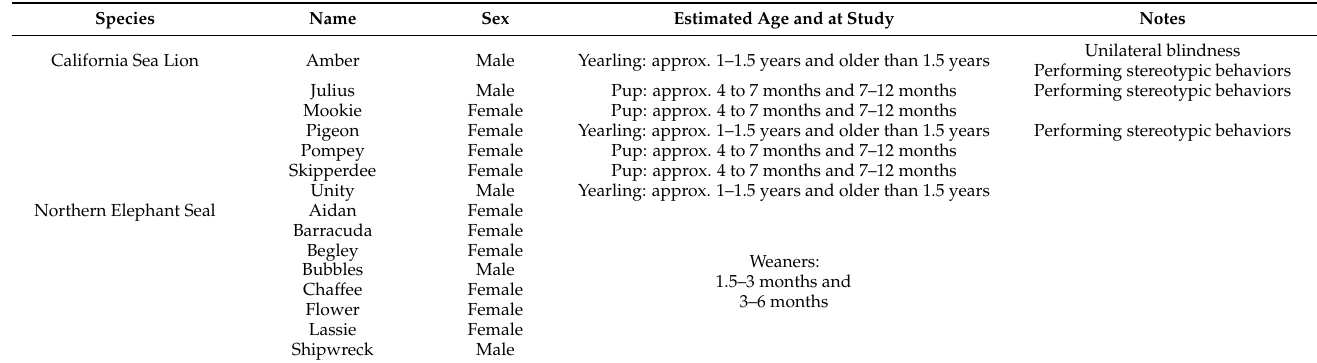
Table 1. Name, sex, age and species of animals in the present study.